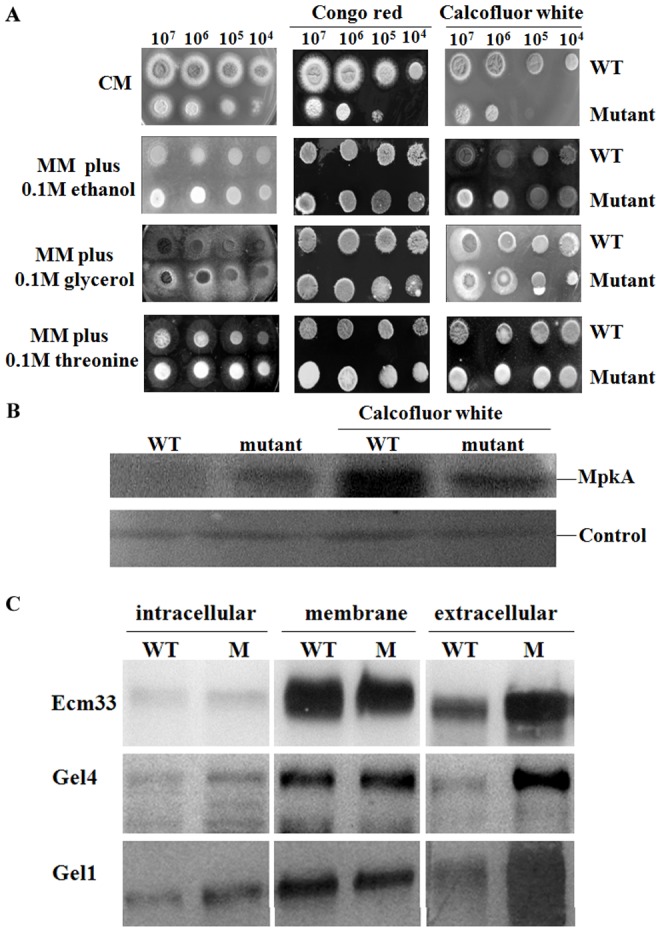
Cell wall defect, activation of MpkA and ER stress in the conditional afpig-a mutant.In A, a series of 10-fold dilutions (107–104 cells) of spores was spotted onto solid CM or MM supplemented with 0.1 M ethanol, 0.1 M glycerol, 0.1 M threonine containing 250 µg/ml Congo red or 250 µg/ml calcofluor white. The plates were incubated at 37°C for 36 h and photographed; in B, a Western blotting was carried out using an anti-phospho-p44/42 MAPK (Erk1/2) (Thr202/Tyr204) antibody. 50 µg of total protein from the wild-type (WT) or mutant strain cultivated in CM at 37°C for 36 h were extracted, separated by SDS-PAGE, transferred to a PVDF membrane and then detected with the antibody. As a control, an anti-RAS antibody was used to detect an unrelated protein; and in C, a Western blotting was carried out using an antibody against the A. fumigatus Ecm33, Gel4, or Gel1.